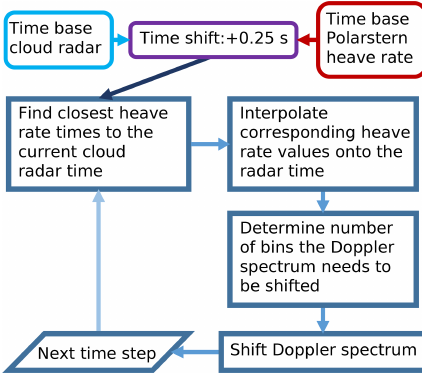
Figure 5. Flowchart of the heave rate